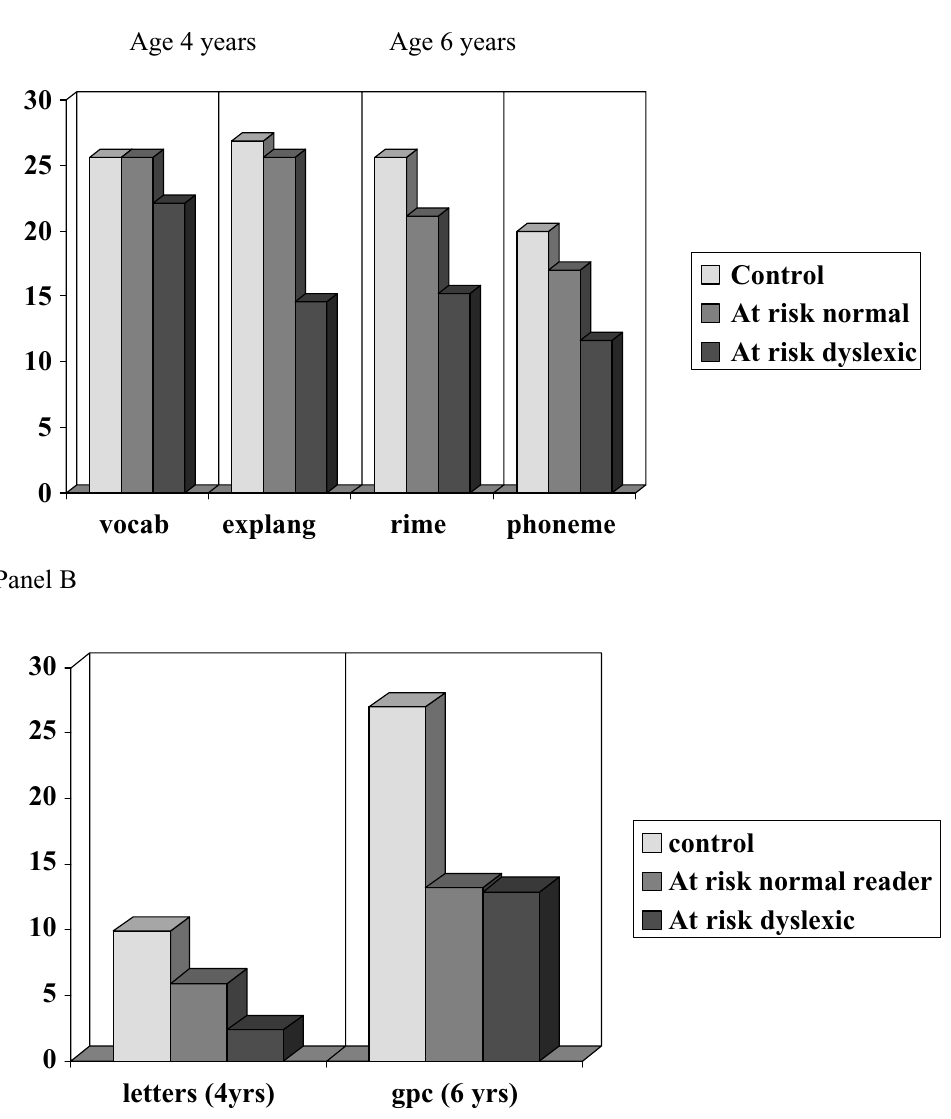
Figure 5. Early language and literacy skills of children at high-risk of dyslexia and controls. Panel A shows that the ‘at risk’ children who went on to be dyslexic were delayed in their early language development (at 4-years) and in the development of phonological awareness (at 6-years). Panel B shows that the ‘at risk’ children who went on to be normal readers at 8-years showed early literacy problems; their letter knowledge was moderately impaired at 4-years and they were impaired in translating between graphemes and phonemes at 6-years (after Snowling et al .,